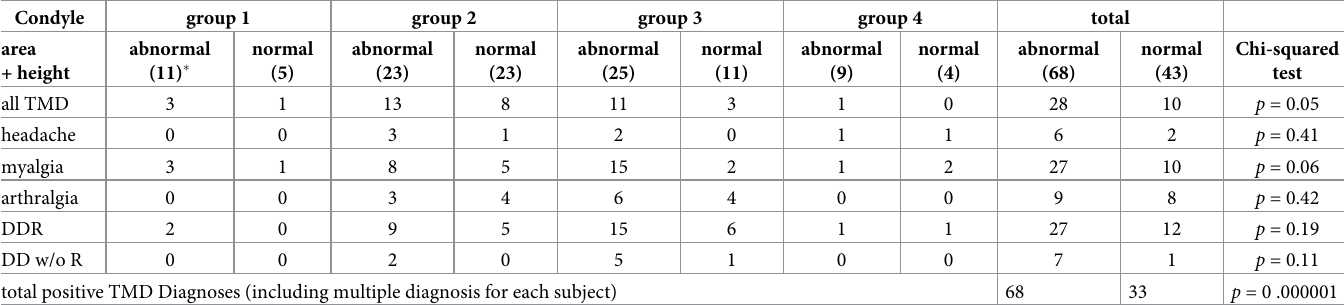
Table 3. Differences in TMD diagnosis between normal and abnormal condyle modeling.